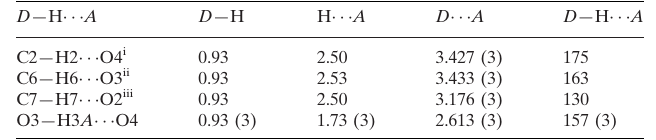
Hydrogen-bond geometry (A˚ , (cid:3)